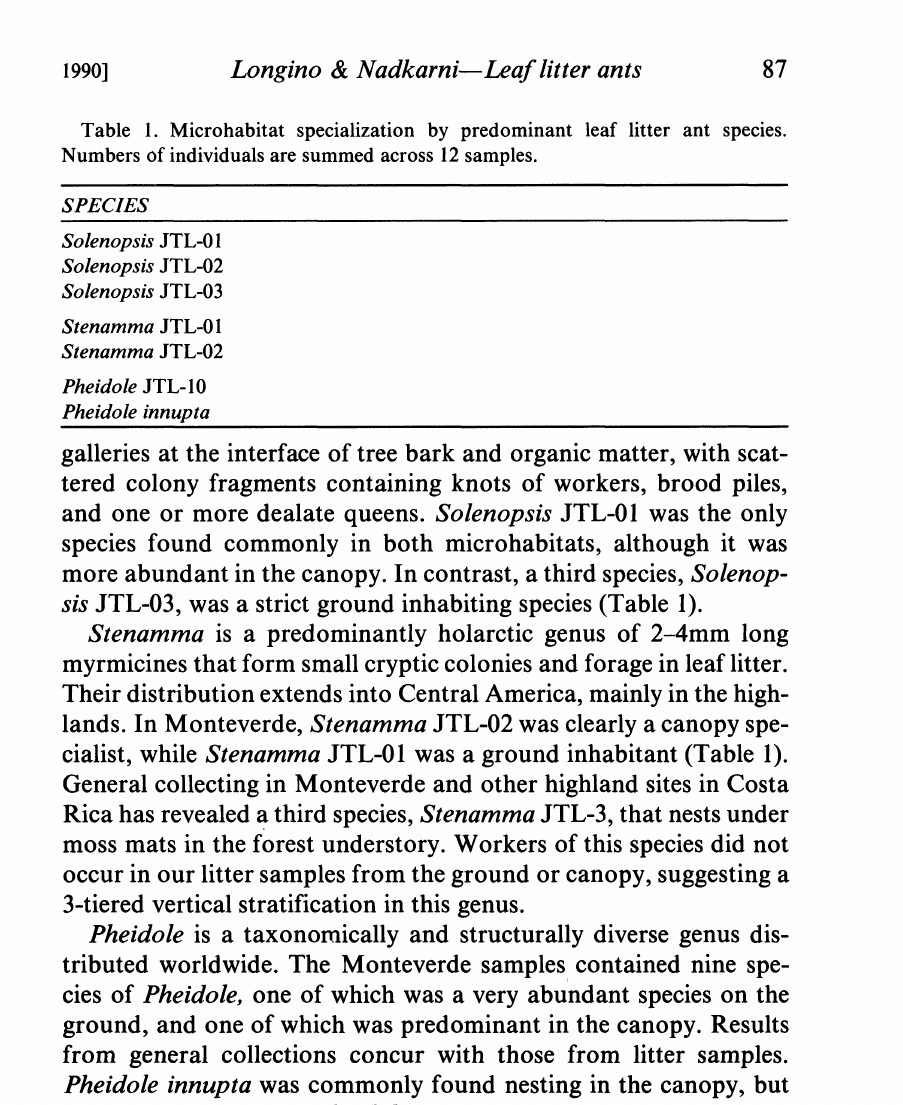
Table 1. Microhabitat specialization by predominant leaf litter ant species. Numbers of individuals are summed across 12